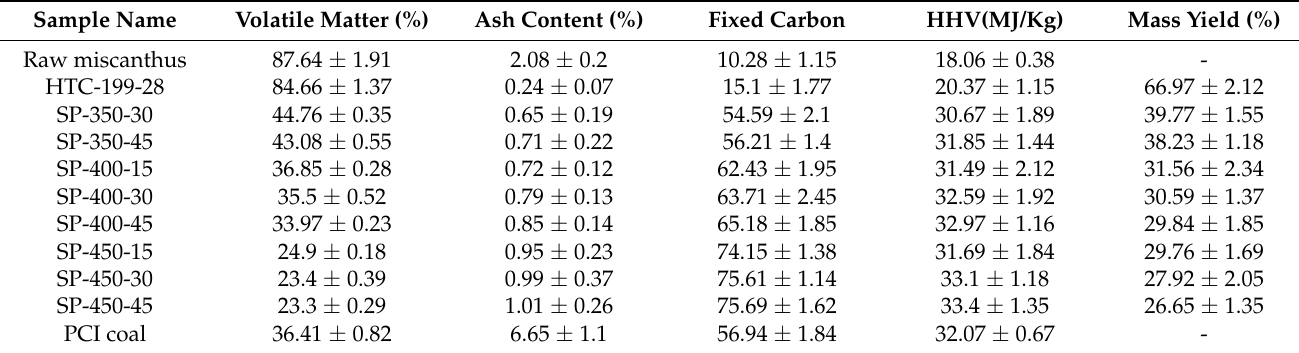
Table 6. Proximate analysis of the optimized HTC biocarbon and slow pyrolysis-derived pyro-biocarbon samples.